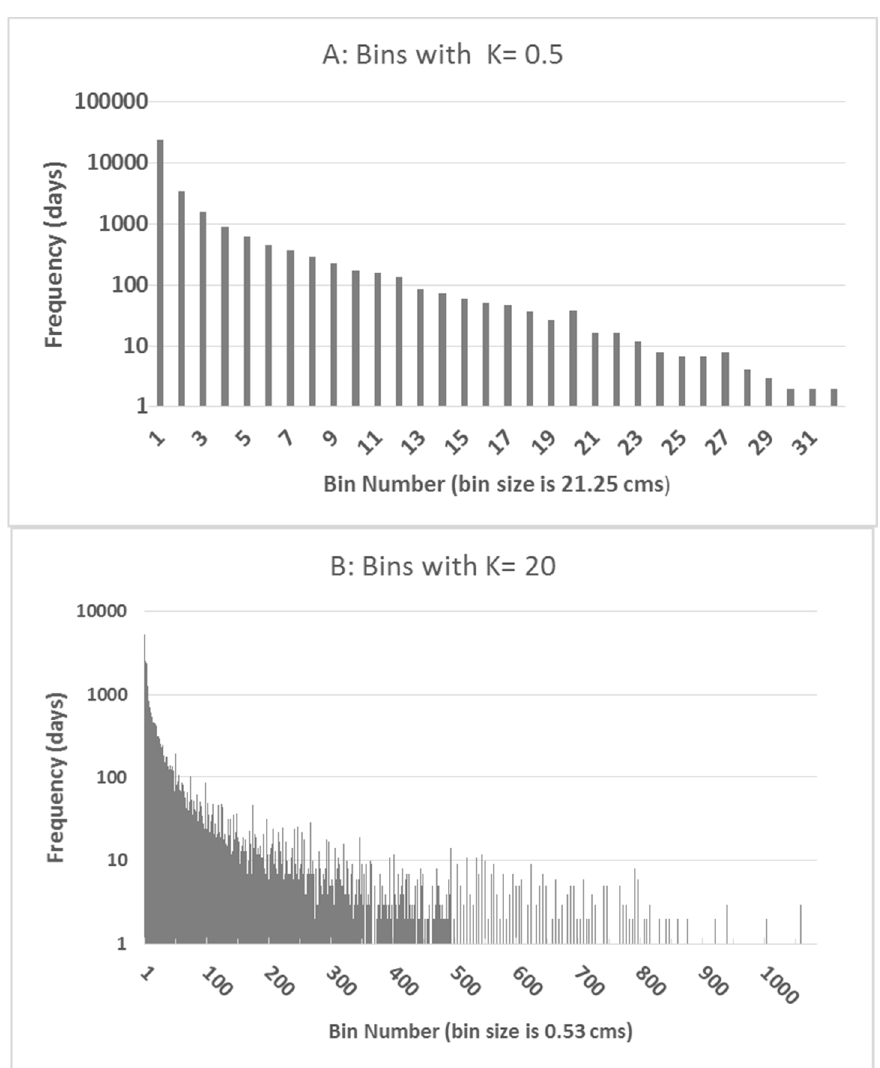
Figure 7. Histograms with K = 0.5 ( A ) and K = 20 ( B ) for the Sandusky River, near Fremont Ohio. A bin with a bin number of 1 has all discharges less than 21.25 m 3 /s (K = 0.5) and 0.53 m 3 /s (K = 20). A bin with a bin number of 10 (K = 0.5)) contains discharges between approximately 229.0 and 229.07 m 3 /s. A bin with a bin number of 400 (K = 20) contains discharges between approximately 229.07 and 229.64 m 3 /s.